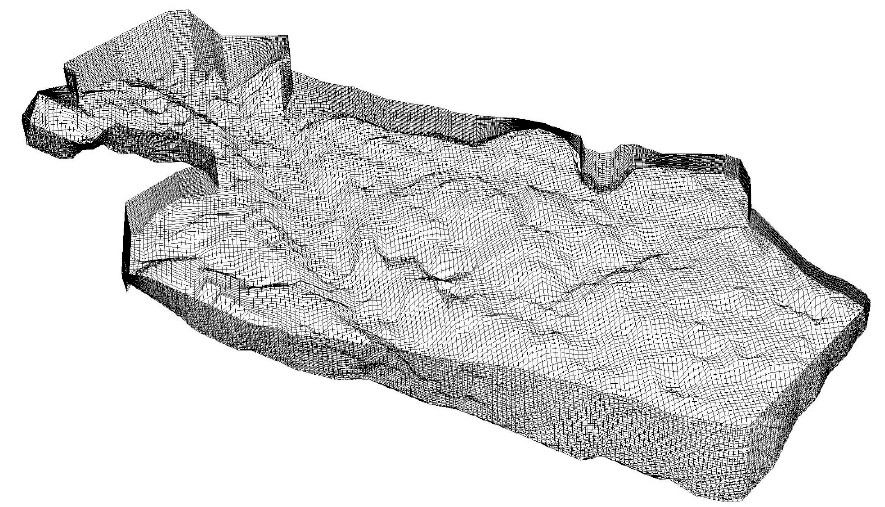
Figure 4. Scheme of the computational domain. Computational grid. For sufficient visualization, the vertical size is increased by 40 times.